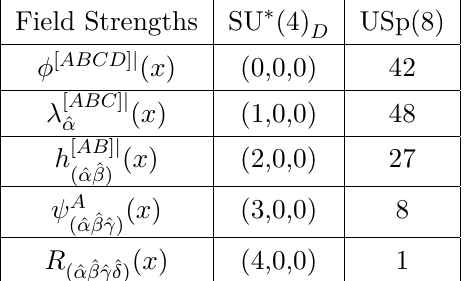
Table 3 . (4,0) doubleton supermultiplet of OSp(8 ∗ | 8) . First column lists the field strengths corresponding to actual physical degrees of freedom. Second column gives their Dynkin labels under the Lorentz group SU ∗ (4) . Third column gives the dimensions of their USp(8) representations. The field strengths are labelled by chiral SU ∗ (4) spinor indices ˆ α, ˆ β, . . . and USp(8) indices A, B, . . .